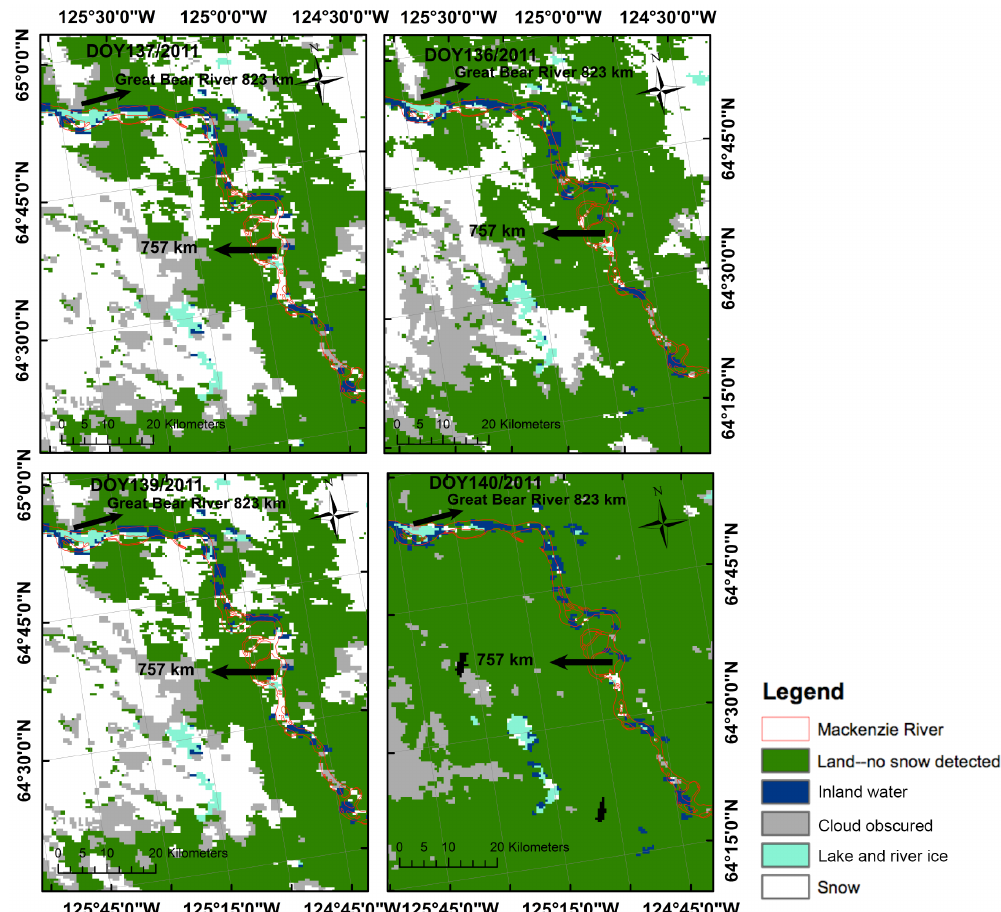
Figure 9. Snowmelt and ice run over the Mackenzie River basin in 2011 between the DOYs 137 and 140. There is a 2-day lag between the complete clearance of snow on land and the clearance of ice on the Mackenzie River.